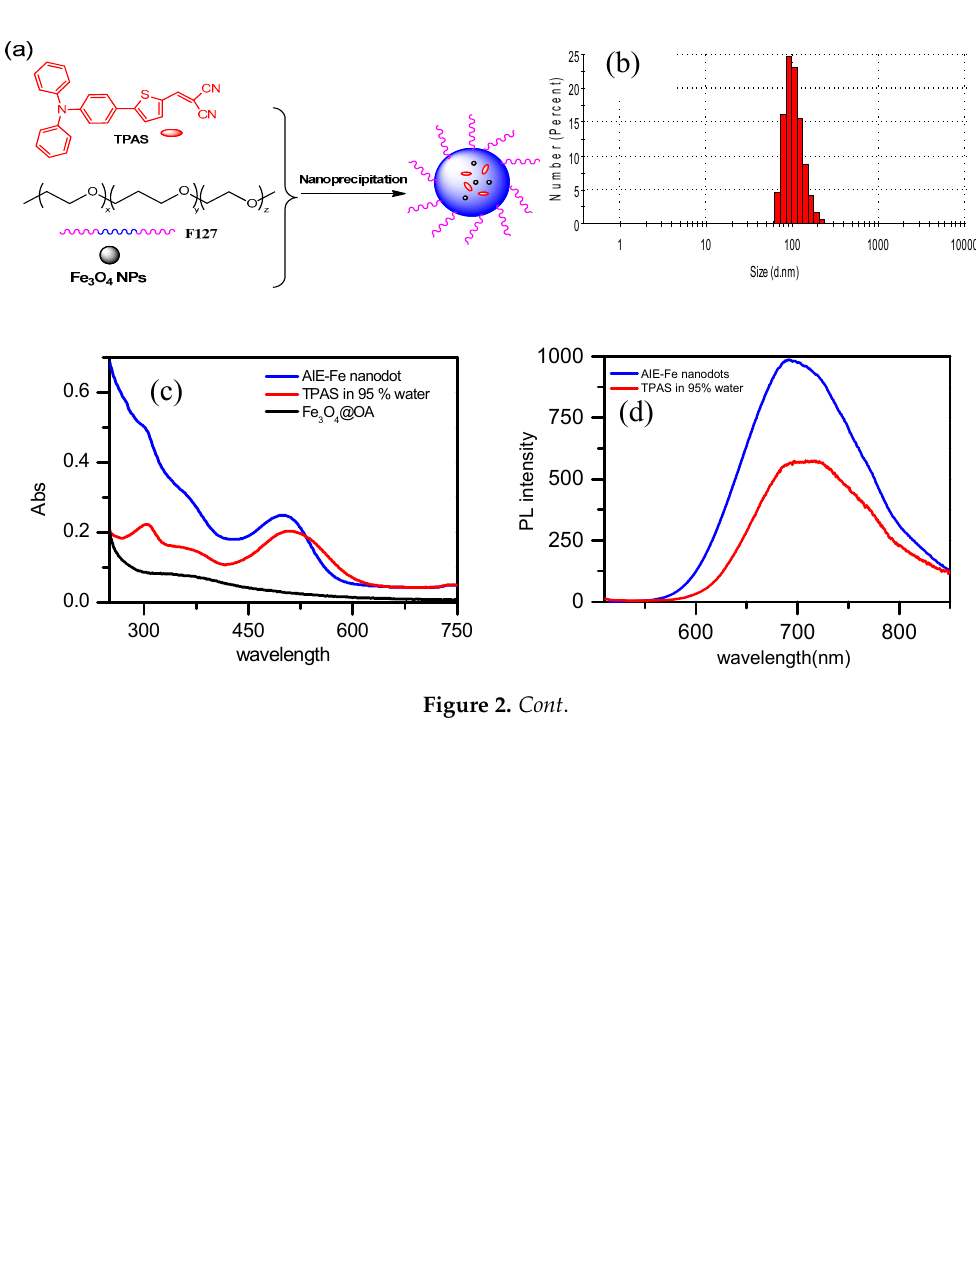
Figure 1. ( a ) Synthetic routes of target dye TPAS. ( b ) The emission spectra of TPAS (10 μ M) in CH 3 CN/water mixtures with different fraction of water ( λ em = 494 nm). ( c ) The fluorescence intensity ratio in presence of different fraction of water. ( d ) TPAS in solid state. Inset: photographs of TPAS in solid state under 365 nm UV